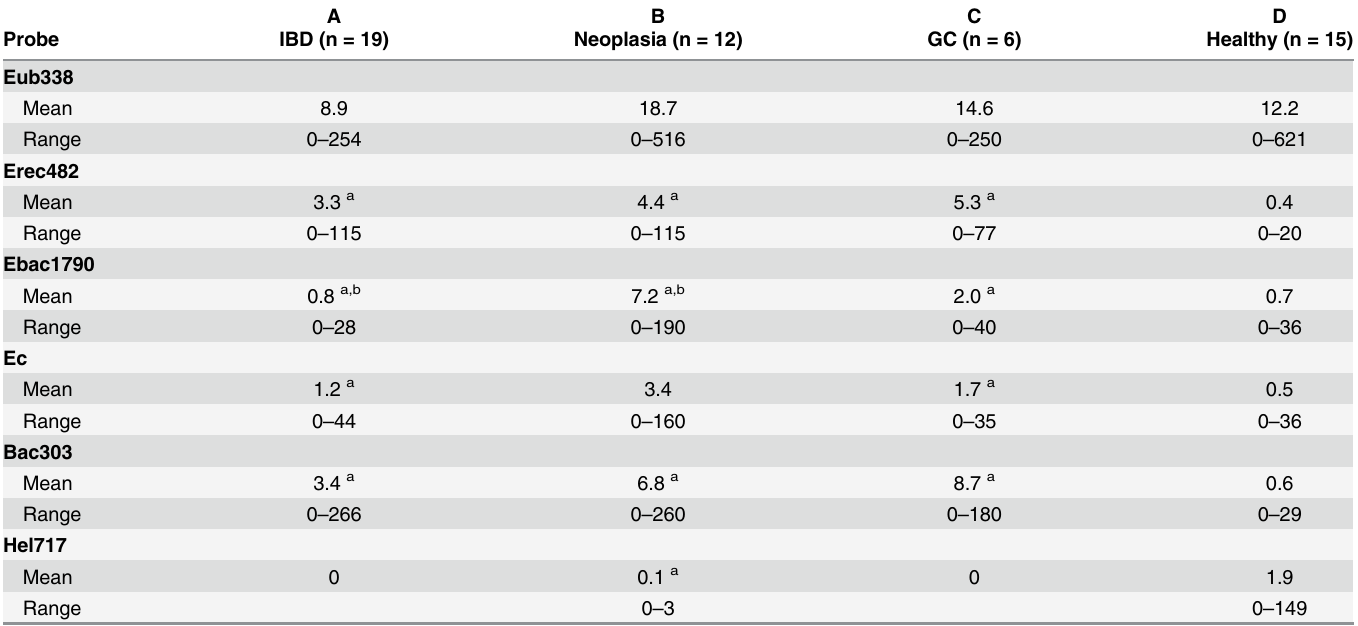
Table 4. Number of ileal bacteria in healthy and diseased